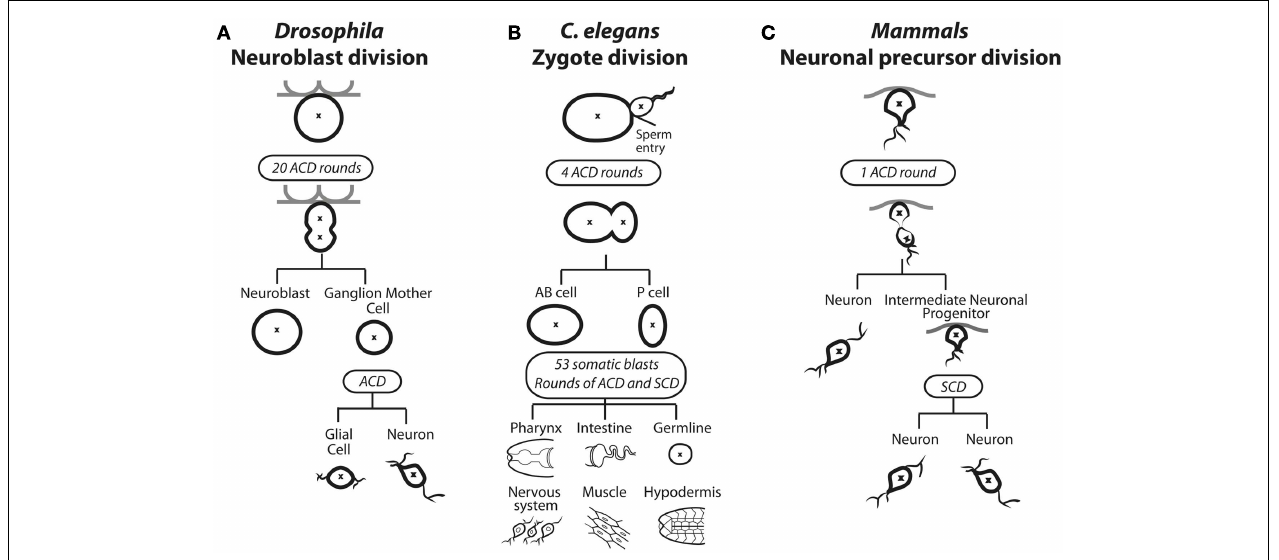
cell fate determining proteins as well as spindle asymmetry. During the embryonic stage four rounds of ACD results in the emerging anterior body (AB) and posterior (P) cells. During the larval stage, 53 somatic blasts undergo bursts of ACD and symmetric cell division (SCD), specifying all future posterior or soma fates in various tissues. (C) Neuronal precursor asymmetric division in mammals.The first asymmetric cell division produces a neuron and an intermediate neuronal precursor (INP), which undergoes a symmetric division to produce two